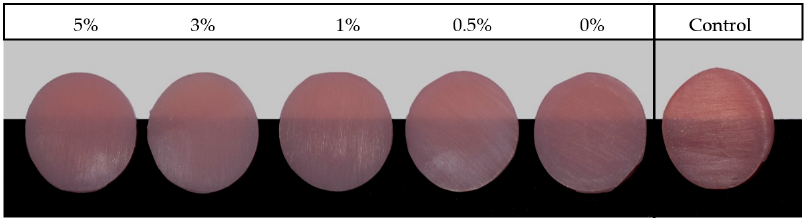
Figure 2. Representative photographs of the ASIGA resin specimens ordered according to ZrO 2 NP concentration. Table 3. Translucency mean values, SD, and significance between HP and NextDent test groups. Material